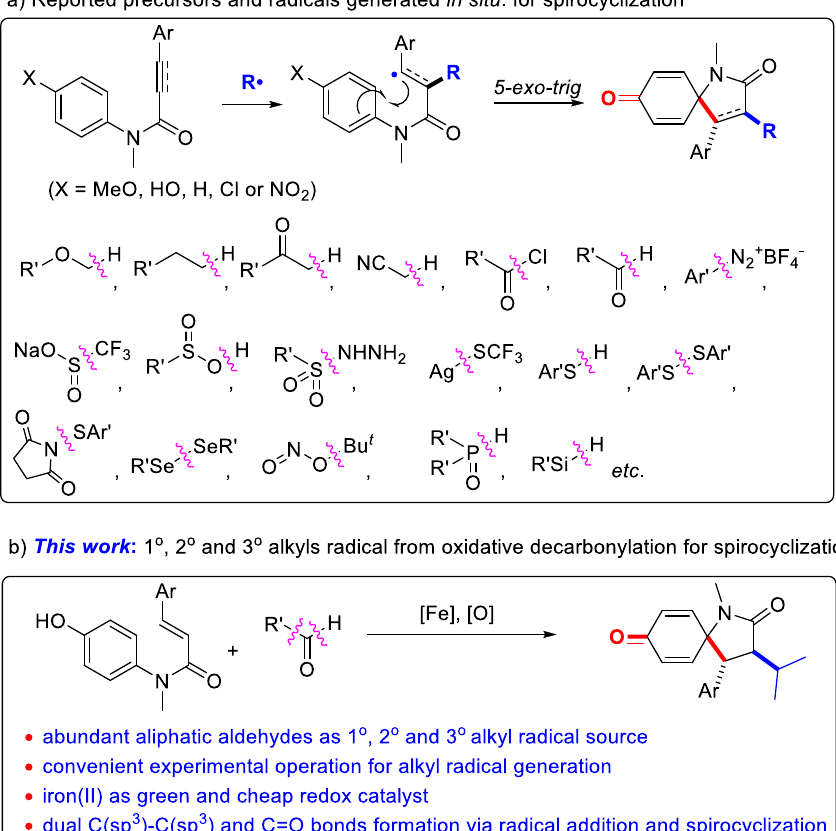
Figure 1. Representative azaspirocyclohexadienone-based bioactive molecules.